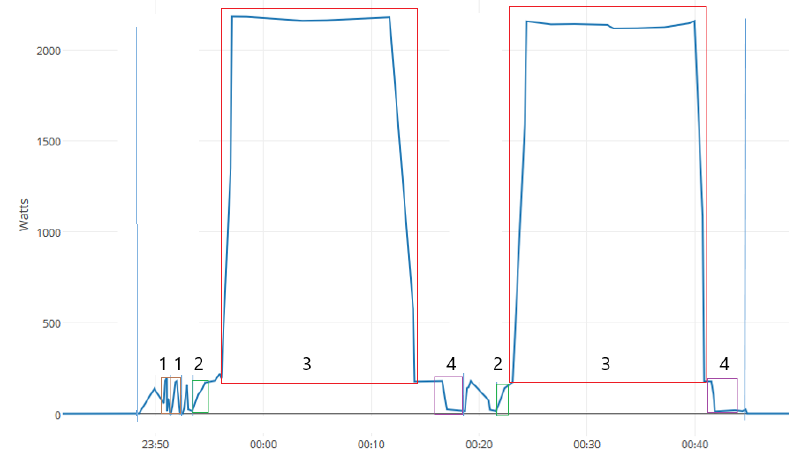
Figure 5. A washing machine consumption’s curve after motif